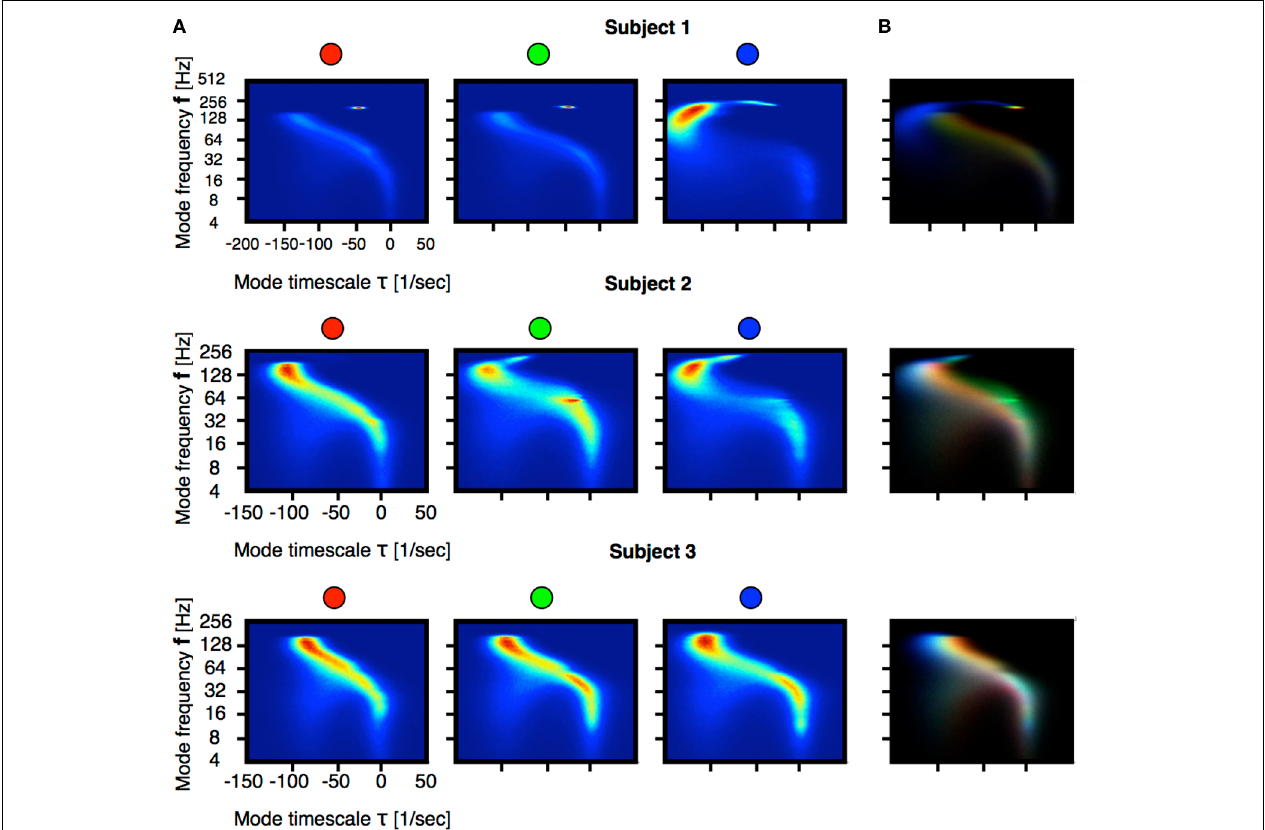
of eigenvalues. (B) Differences across segments. We normalized each bin in (A) histograms by their maximum. The figure is constructed by superposing the three histograms, each coding for a color in RGB space. In this way pure red, pure green and pure blue correspond to eigenvalues that are only present in the first, second and third stage. The rainbow-like pattern indicates a shift of high frequency modes as they become more